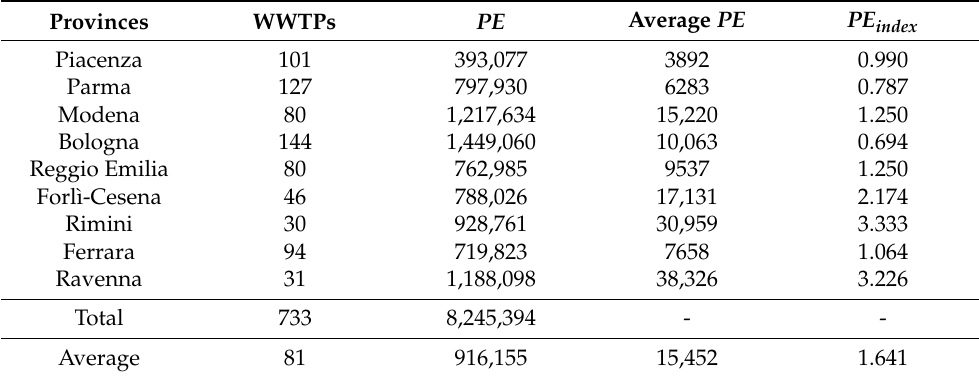
Table 3. Computation of the PE index value for the provinces of the Emilia-Romagna region.